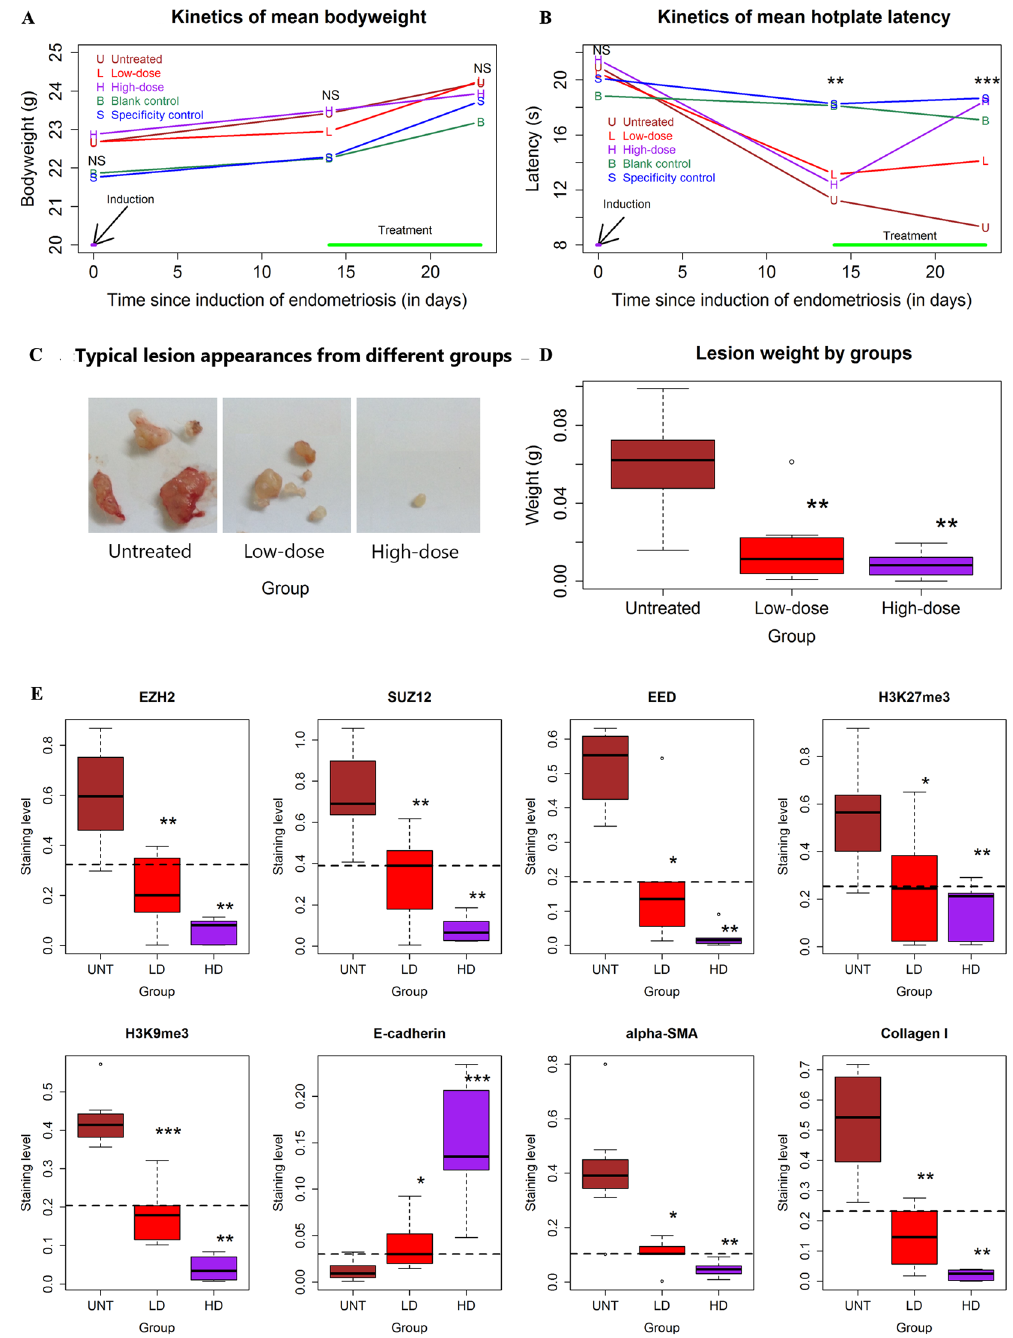
Figure 4. EZH2 inhibition by DZNep reduced the growth of endometriosis in vivo , concomitant with suppressed expression of EMT markers and of fibrogenesis. The kinetic changes of bodyweight ( A ) and hotplate latency ( B ) of mice treated with or without DZNep were analyzed. The mice with induced endometriosis were randomly divided into 3 groups of equal sizes: Untreated group (U, n = 8), low-dose DZNep group (L, n = 8) and high-dose DZNep group (H, n = 8). The mice with sham induction were randomly divided into two groups in average: blank control group (B, n = 7) and specificity control group (S, n = 7). ( C and D ) Representative images of ectopic lesions ( C ) and quantification of lesion weight ( D ) in mice with induced endometriosis treated with DZNep or vehicle. ( E ) Quantitative comparison of EZH2, EED, SUZ12, H3K27me3, H3K9me3, E-cadherin, α -SMA and Collagen I expression between mice with induced endometriosis treated with or without DZNep. Immunoreactivity against EZH2, EED, SUZ12, H3K27me3, H3K9me3 and E-cadherin in endometriotic epithelial cells was evaluated while the immunoreactivity against α -SMA and collagen I in endometriotic stromal cells was evaluated in mice treated with or without DZNep. DZNep significantly abrogated the expression of EZH2, EED, SUZ12, H3K9me3, H3K27me3, α -SMA and Collagen I while elevated E-cadherin expression in ectopic endometrial epithelial cells, all in a dose-dependent manner. NS: not statistically significant. * P < 0.05; ** P < 0.01; *** P <